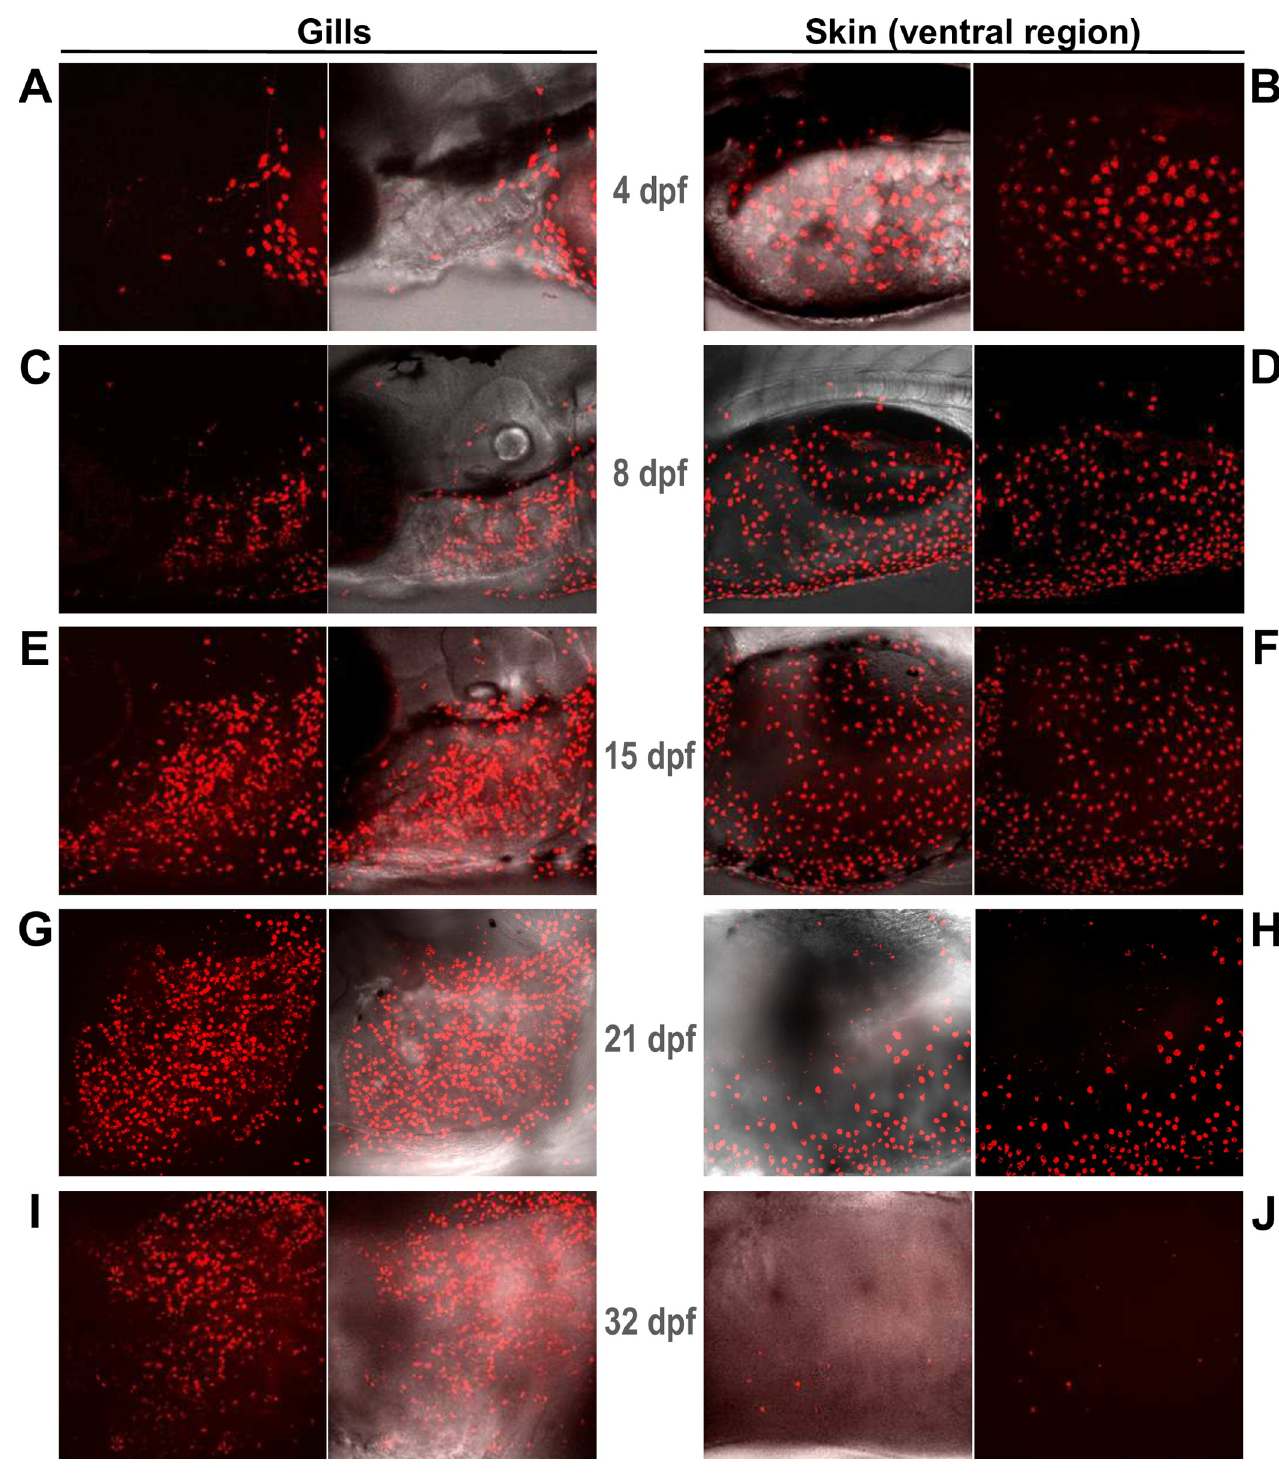
Fig 7. Evolution of CEACAMz1 expression in gills and on ventral skin at late larval stages. Live imaging of larvae from the Tg(ceacamz1 : mCherry-F) reporter line using spinning disk confocal microscopy at various developmental stages: 4 dpf ( A-B ), 8 dpf ( C-D ), 15 dpf ( E-F ), 21 dpf ( G-H ), 32 dpf ( I-J ). Visualization around the gill region ( A,C,E,G,I ) or on the ventral skin region ( B,D,F,H,J ).